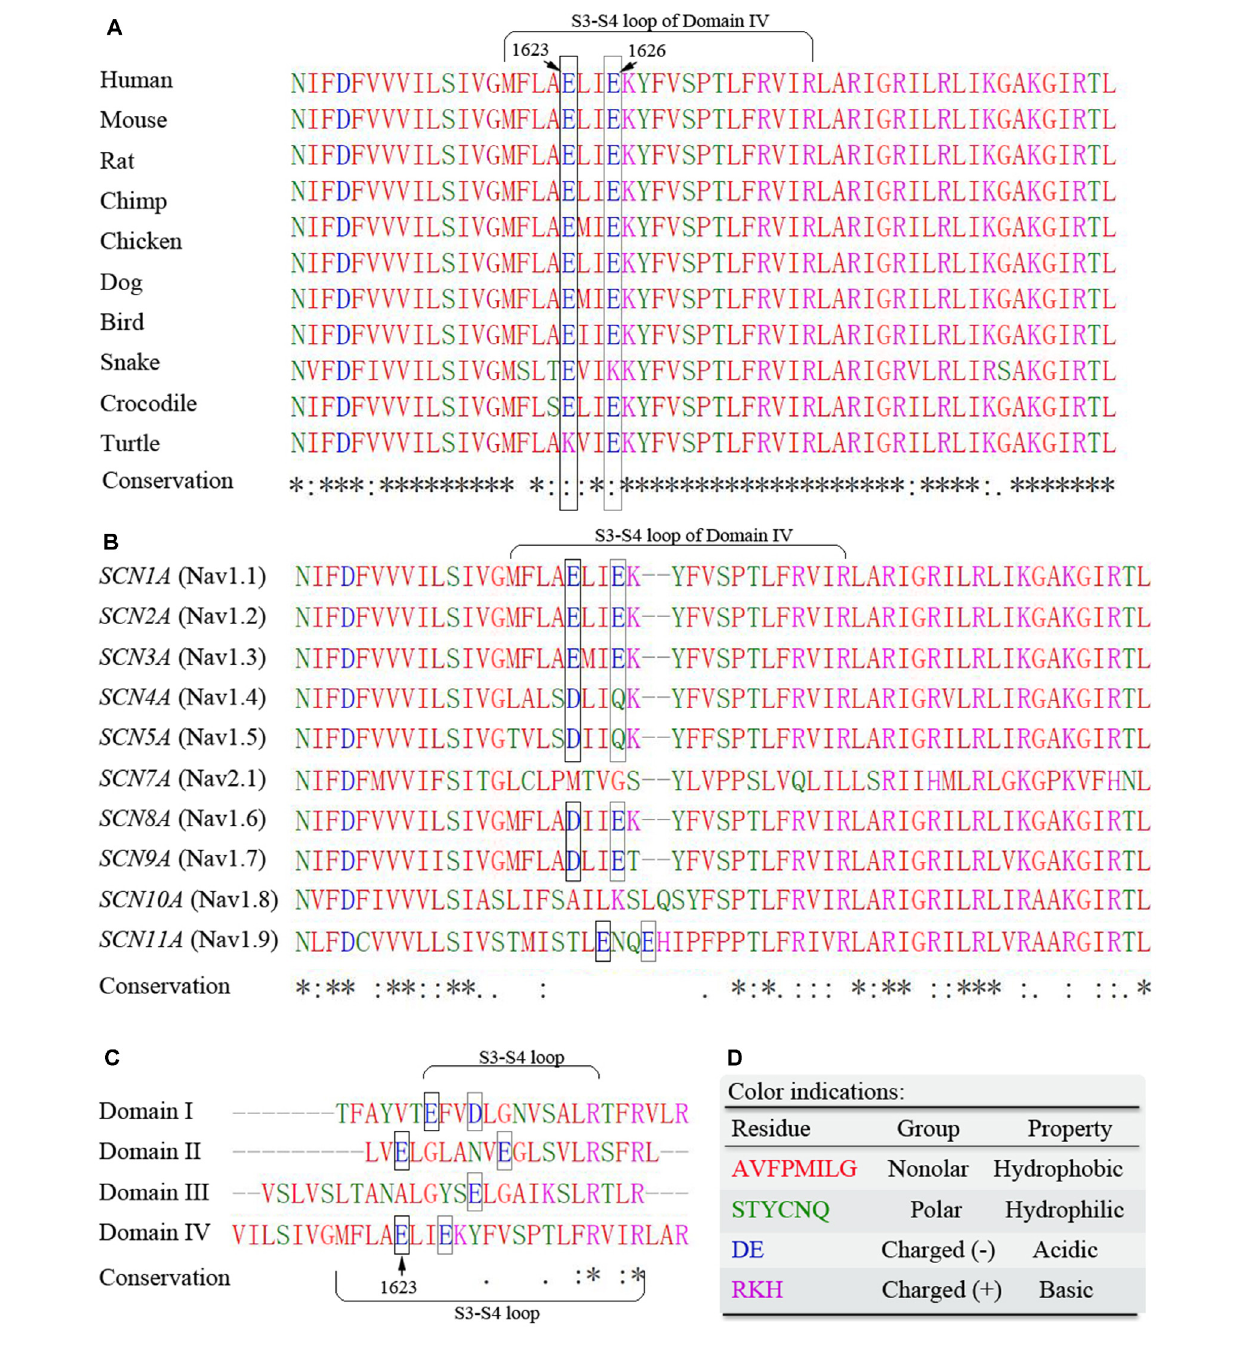
FIGURE 2 | Multiple sequence alignments of the S3-S4 extracellular loop of DIV. (A) Cross-species alignments show high conservation of amino acid sequence within the region. (B) Sequence alignments among Na v family members indicate high conservation of two acidic residues E1623 and E1626. (C) Differences in sequence length and residues of the S3-S4 loop among different domains of human Na v 1.1 alpha unit. (D) Color indications. Residues are grouped by their physicochemical properties and indicated by different colors. The symbols of conservation significance are in keeping with the Clustal Omega from the NCBI website. * fully conserved; : conservation with strongly similar properties; . conservation with weakly similar properties; blank space indicates not conserved. The potentially important acidic residues are highlighted with frames. the slope of steady-state activation between E1623A and WT operate as amplifiers of subthreshold depolarization. The mutant ( Figure 5A ). The depolarized voltage dependence of activation E1623V showed similar alteration, and the other mutants caused may reduce the availability of the E1623A mutant channels to slight alterations of activation parameters without